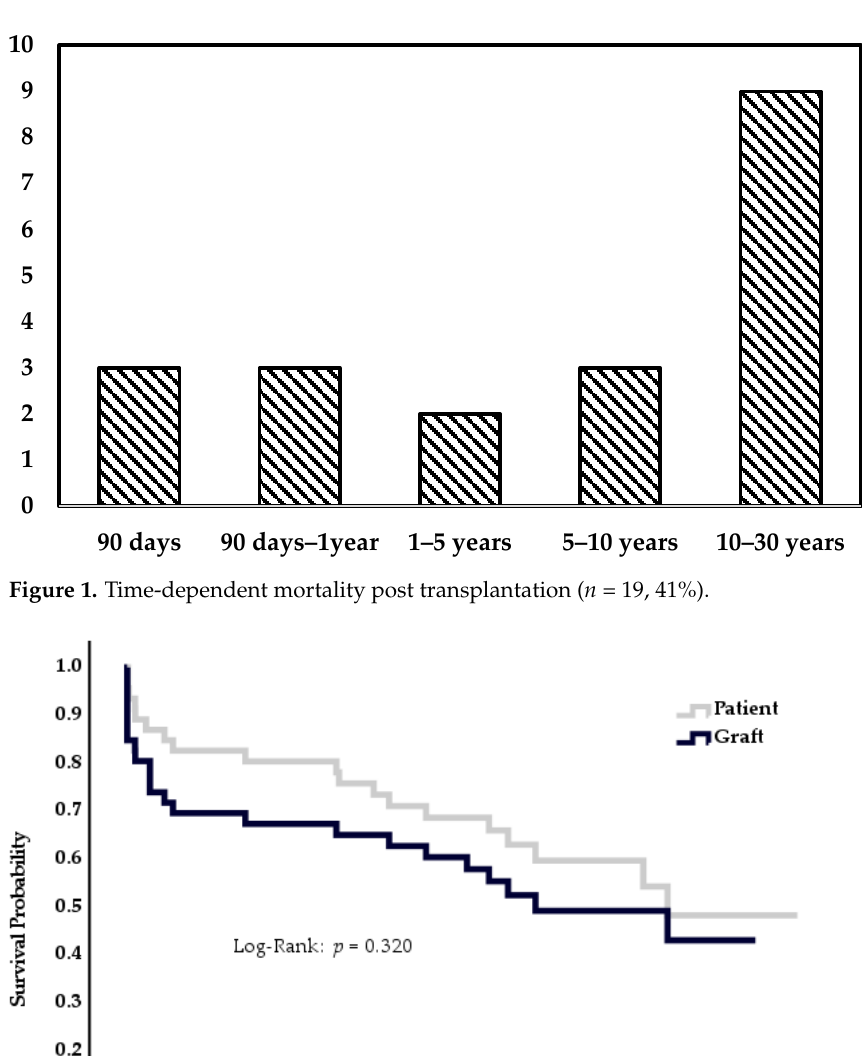
Figure 3. Cumulative survival—Budd-Chiari syndrome ( n = 46) vs. other indications ( n = 2677). 1 year